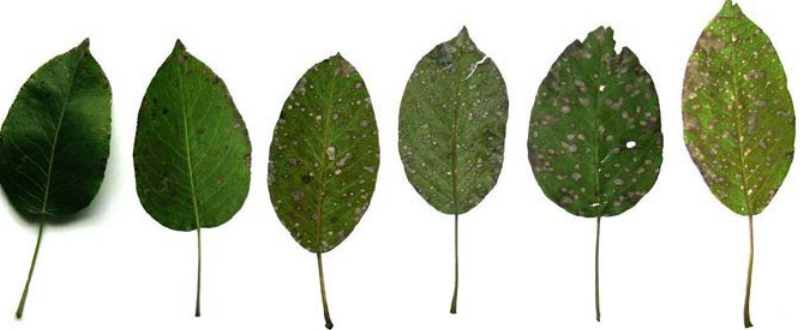
Figure 6. The progressive system of scale classes or grading correspondingly assigned to percentage intervals of attack intensity. For Septoria pyricola , the order represents the ascending grades related to the proportion of leaf damage (1 = 1–3%, 2 = 4–10%, 3 = 11–25%, 4 = 26–50%, 5 = 51–75%, 6 = 76–100%) in a system that allows a quick visual analysis for a large number of data.